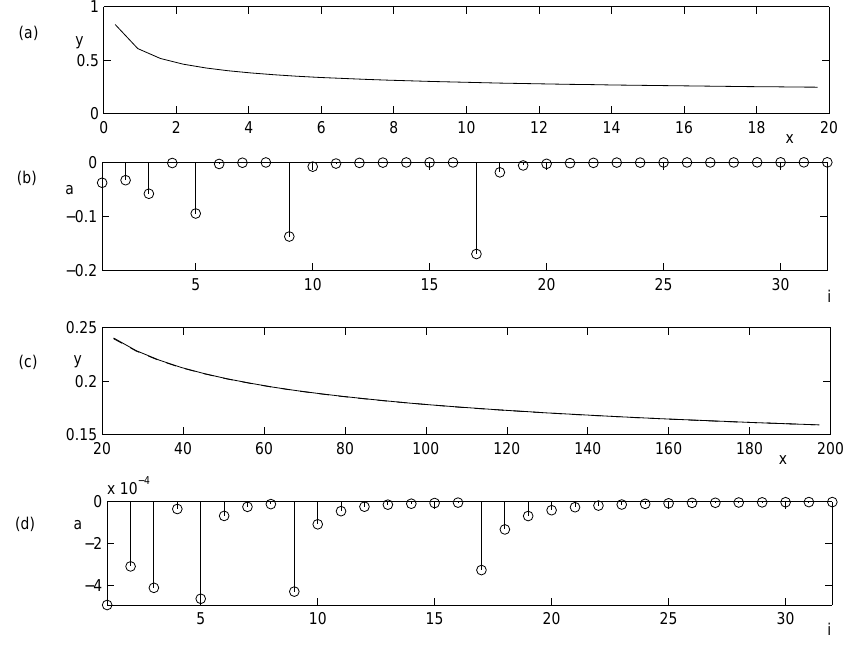
Figure 2. Solution of (4.3) for J = 4 (a) first phase x ∈ [0 , 20] ; (b) wavelet coefficients a ( i ) for this phase; (c) second phase x ∈ [20 , 200] ; (d) wavelet coefficients for the second